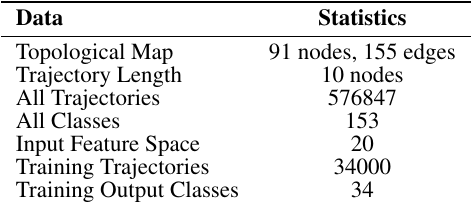
Table 1. The original dataset